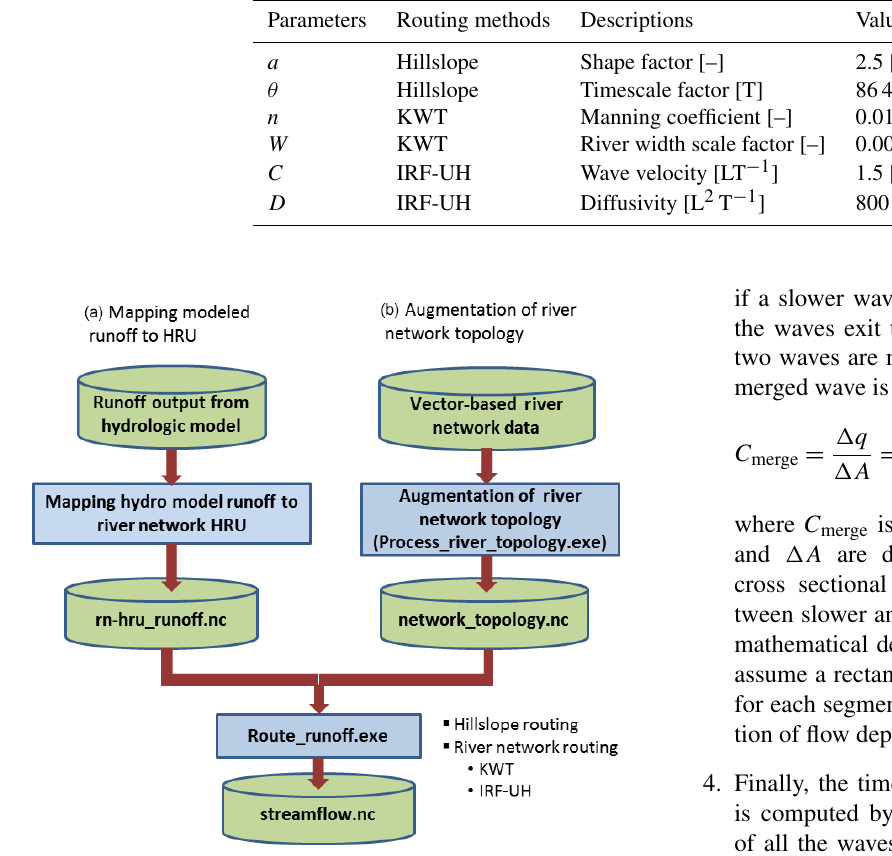
Figure 3. Overview of streamflow simulation with mizuRoute. The green cylinder and blue box denote data and computational process,